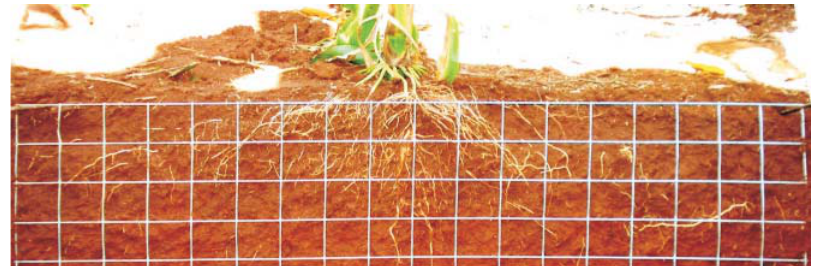
Figura 2. Distribuição radicular do milho em Latossolo Vermelho distroférrico sob plantio direto. A dimensão do perfil estudado é de 0,9 x 0,2 m e cada quadrícula possui 0,05 x 0,05